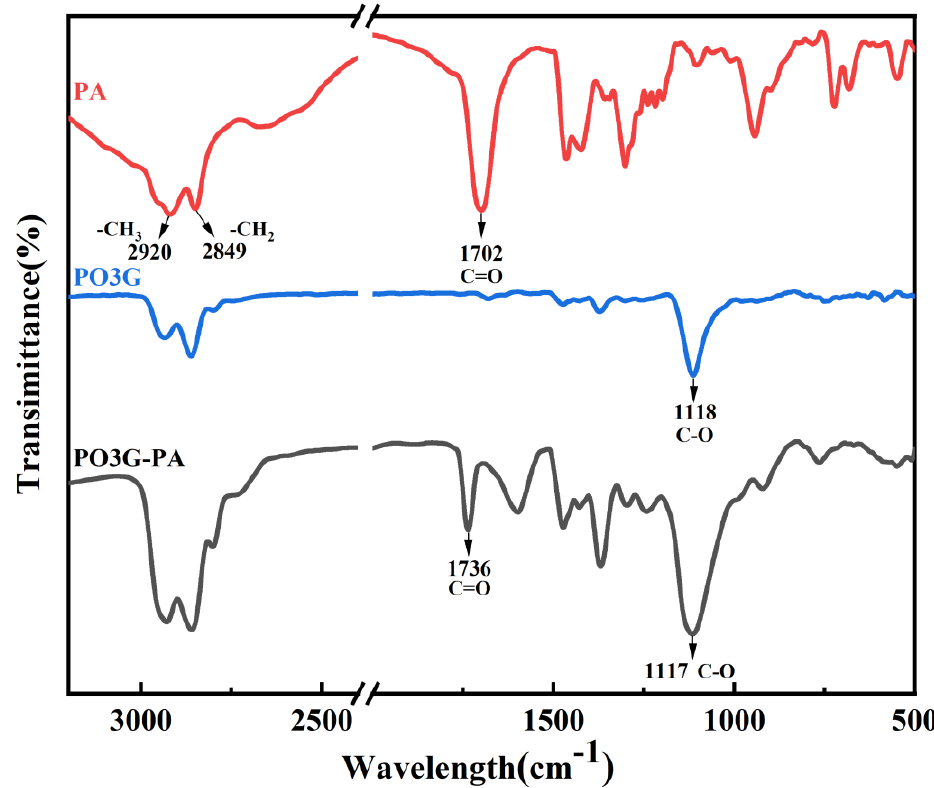
Figure 3. FTIR spectra of PA, PO3G, and PO3G–PA.